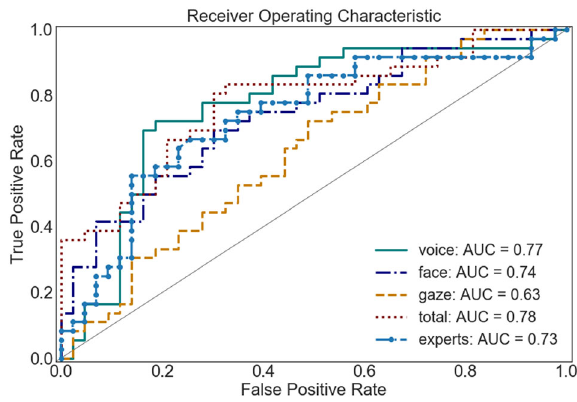
Fig. 5 ROC curves of all classi fi